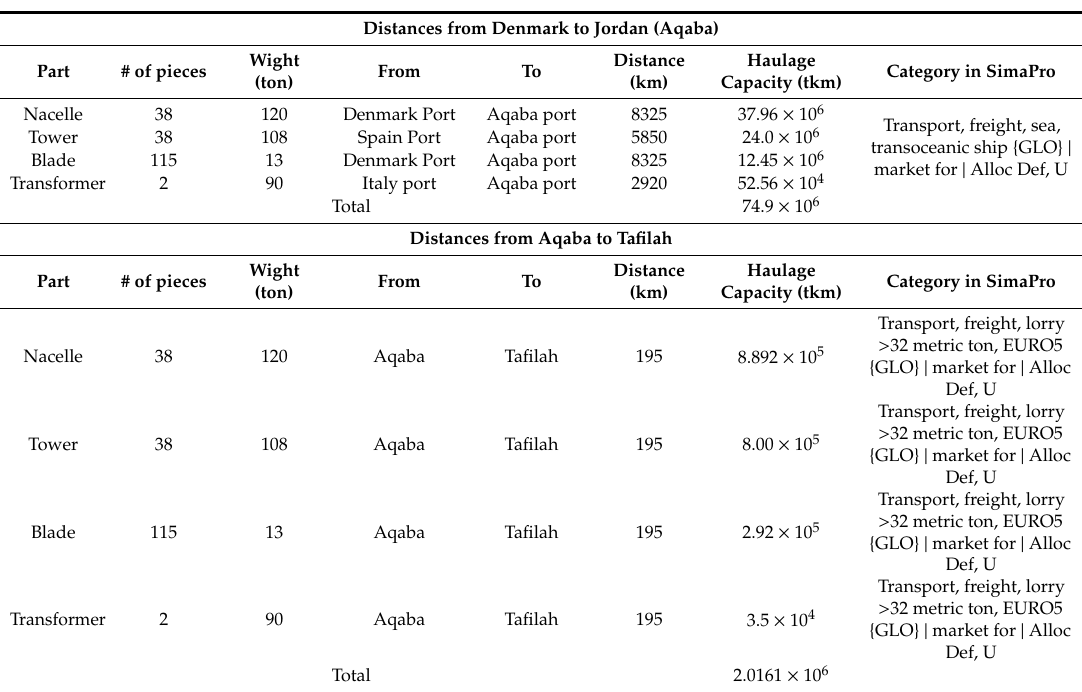
Table 4. Transportation distances from Denmark port to Jordan port (Aqaba) and from Aqaba to Tafilah. Distances from Denmark to Jordan